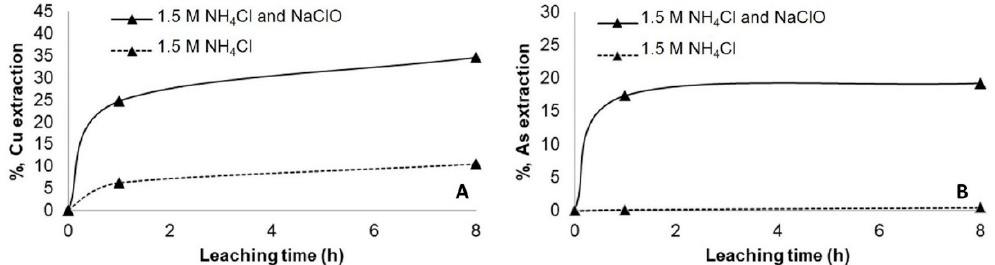
Figure 6. Copper ( A ) and arsenic ( B ) extraction at ambient condition using 1.5 M of (NH 4 )Cl with and without the addition of 10 g/L NaClO.